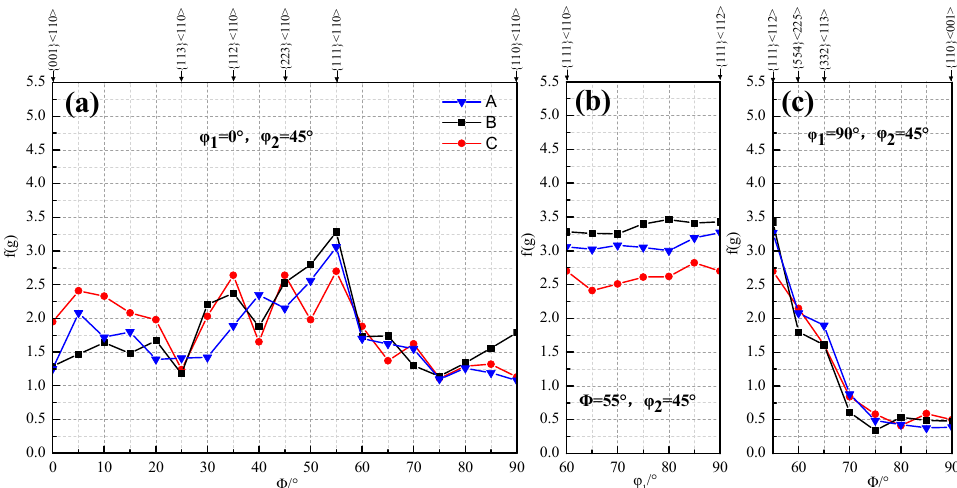
Figure 4. Texture distribution with different secondary cold reduction rates on the different oriented lines: ( a ) RD; ( b ) ND; ( c ) TD.